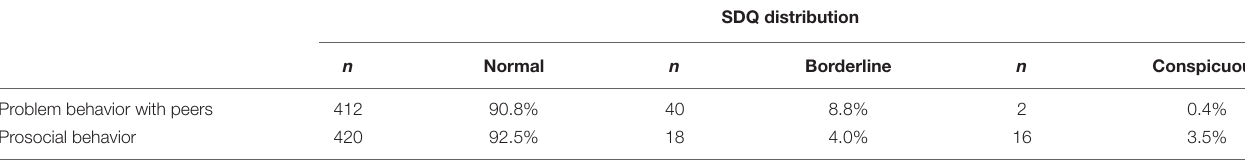
TABLE 3 | Classification of the children with a migration background via the SDQ